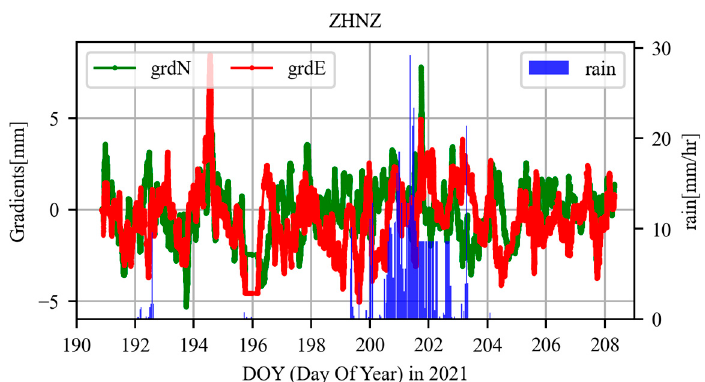
Figure 6. Time series of the horizontal north gradients (grdN) and east gradients (grdE) with respect to the hourly rain at the nearby meteorological station.